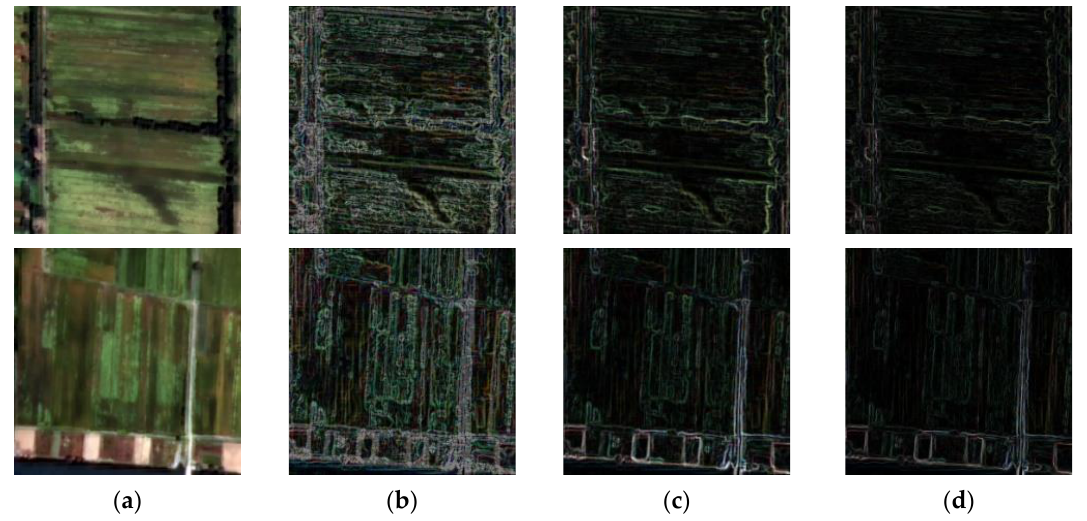
Figure 11. Edge detection results: ( a ) original image; ( b ) results of the Scharr operator; ( c ) results of the Prewitt operator; ( d ) results of the Roberts operator.